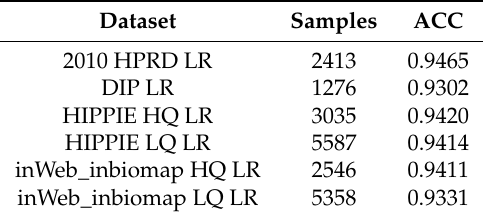
Table 9. DNN-PPI’s accuracy on low-redundancy versions of validation datasets.